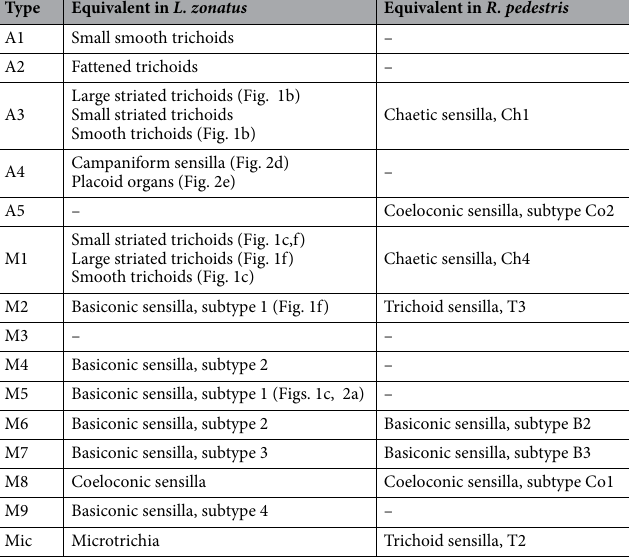
Table 2. Comparison of the identified types of sensory organs with the results obtained for Leptoglossus zonatus 62 and Riptortus pedestris 60 . Figures are also referenced for L. zonatus as the different names used by Gonzaga-Segura et al. 62 refer, in fact, to the same types of